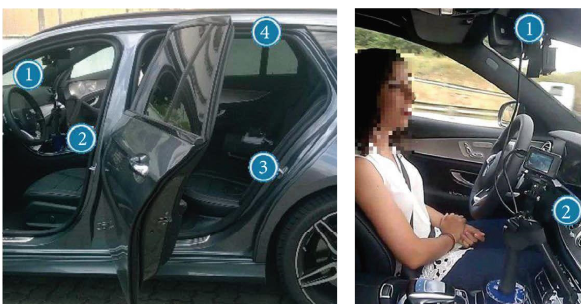
Figure 4: Installed equipment: (1) video camera recording the trafc in front; (2) video camera recording the vehicle interior and dashboard; (3) datalogger; (4) GPS